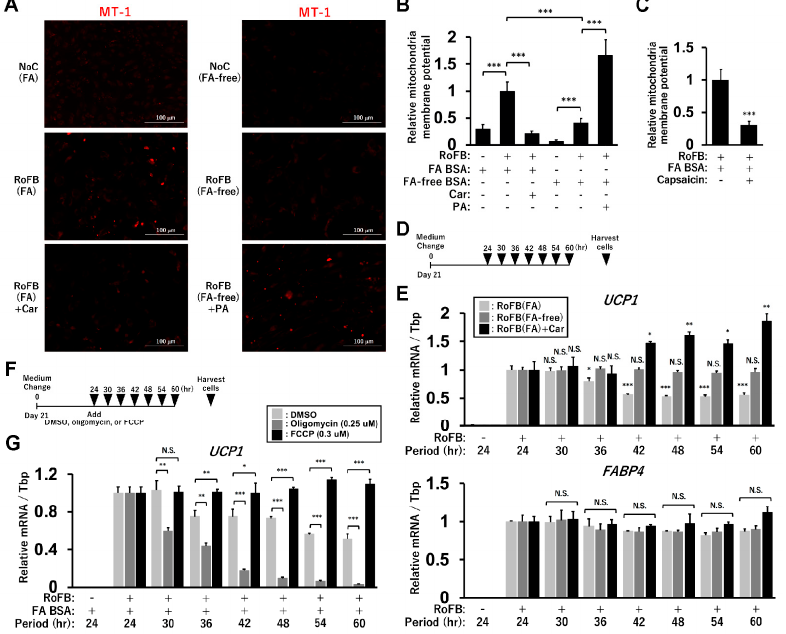
Figure 7. Mitochondrial membrane potential (MMP) affects UCP1 expression in ciBAs. ( A ) MMP was evaluated by staining with the fluorescent probe, MT-1 dye, in ciBAs cultured under various conditions, as indicated. ( B , C ) The area of the staining was quantified using ImageJ software. ( D ) The illustration represents the timing of harvesting ciBAs 24 h after the final medium change on day 21. ( E ) The expression of UCP1 and FABP4 was quantified using qRT-PCR in RoFB(FA), RoFB(FA- free), and RoFB(FA) + Car. The expression level in these ciBAs harvested 24 h after the final medium change was normalized to 1. ( F ) The illustration represents the timing of harvesting RoFB(FA) ciBAs after the addition of either DMSO, oligomycin (0.25 μ M), or FCCP (0.3 μ M). ( G ) The expression of UCP1 was quantified using qRT-PCR in these ciBAs. The expression level in the ciBAs harvested 24 h after the final medium change was normalized to 1. Data represent mean ± SD ( n = 3). Student’s t- test: * p < 0.05, ** p < 0.01, *** p < 0.001, N.S.; not significant.